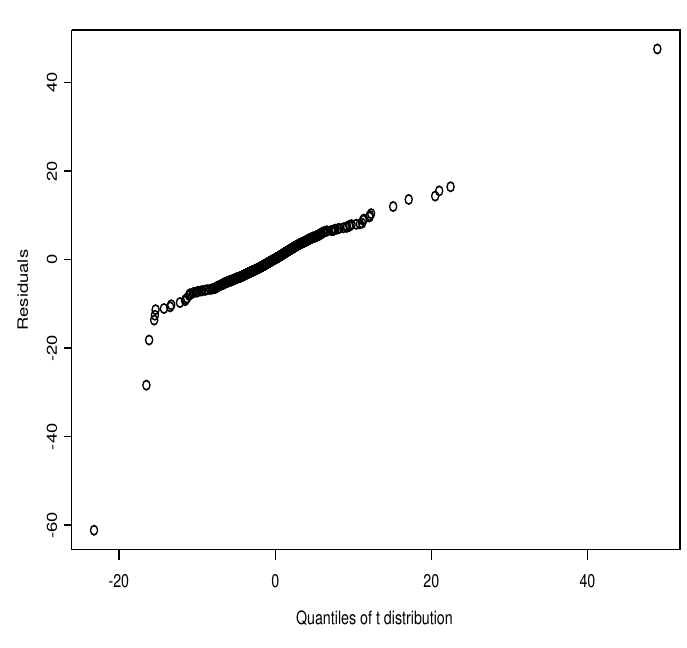
Figure 12. QQ-plot of PHARCH